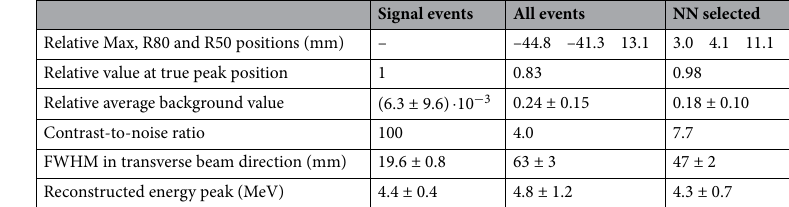
Table 2. Studied parameters of the reconstructed images with the three simulated datasets.